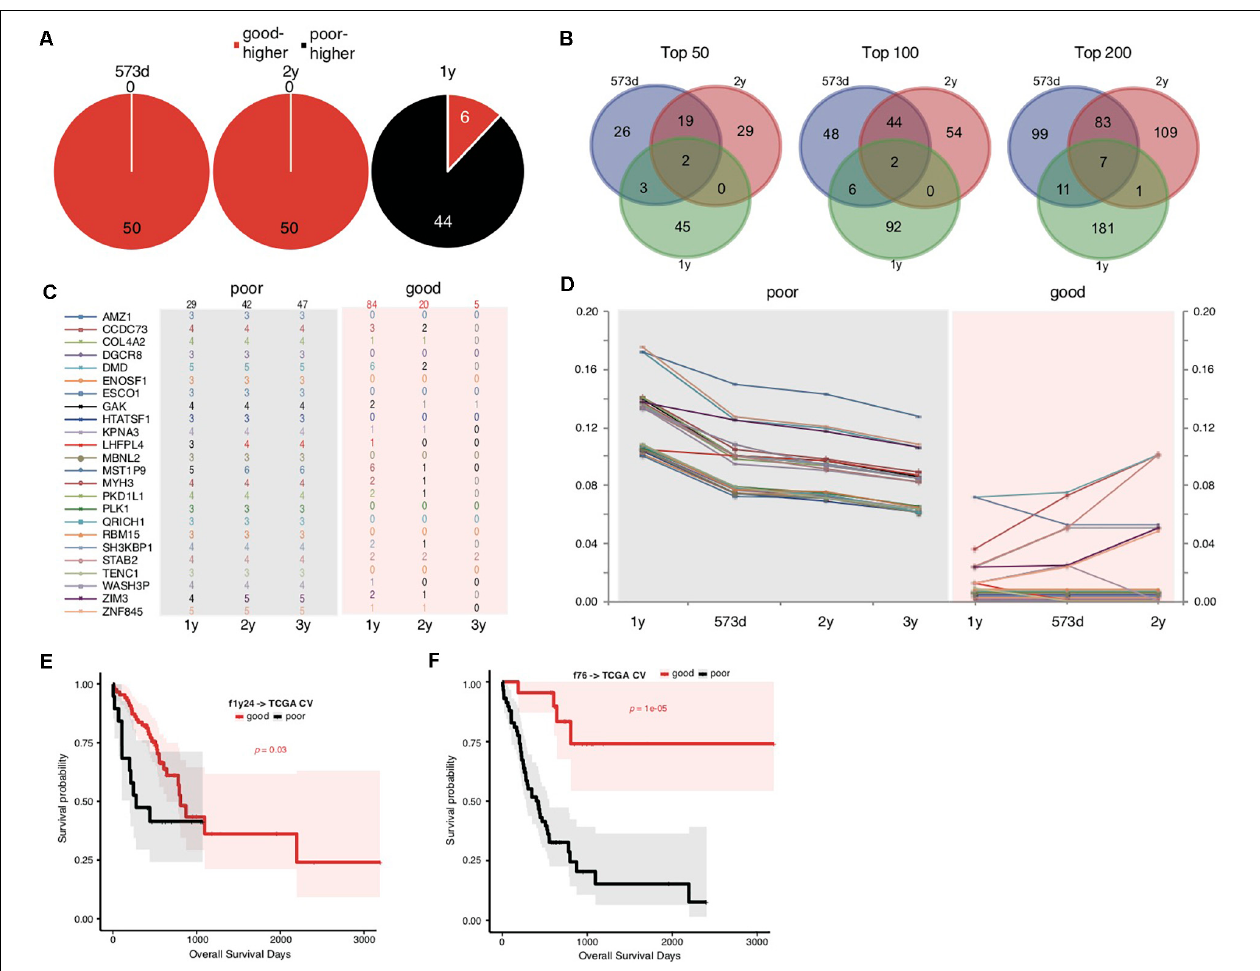
FIGURE 2 | Somatic mutation indicators for poor prognosis of TCGA STADs. (A) The distribution of top 50 significant genes of good and poor prognosis groups stratified with different cutoff survival time. Genes with higher mutation rates were counted for either the good or poor prognosis group and represented as “good-higher” or “poor-higher,” respectively. The total number was also indicated. (B) The consistent intersect among the top significant genes (50, 100, or 200) identified by 573-day, 1-year, and 2-year stratifications. (C,D) The number of cases with mutation (C) and the mutation rate changes (D) of the top 24 significant genes selected in the good and poor prognostic groups stratified by 1 year along with overall survival time. The total case number for either prognostic group stratified by each survival cutoff was shown on the top of (C) . (E,F) The Kaplan–Meier overall survival curves of the TCGA STAD cases stratified by f1y24 (E) or the combined f76 model (F) with a 5-fold cross-validation strategy. Gehan–Breslow–Wilcoxon tests were performed to compare the overall survivals, and the p -values were shown in context.